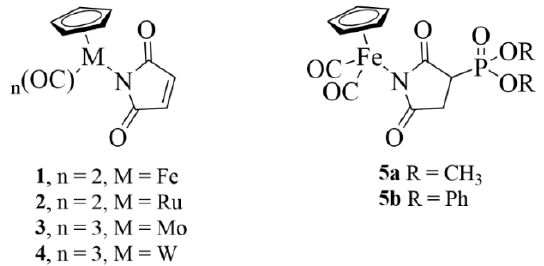
Figure 2. Structure of the metallocarbonyl complexes CpM(CO) n ( η 1 - N -maleimidato) (M = Fe, n = 2 ( 1 ), M = Ru, n = 2 ( 2 ), M = Mo, n = 3 ( 3 ), M = W, n = 3 ( 4 )) and half-sandwich iron phosphonate complexes ( 5a – b ).